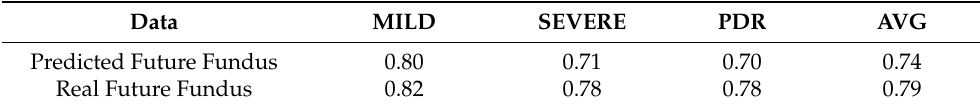
Table 3. Comparison DR severity classification results of each class using the